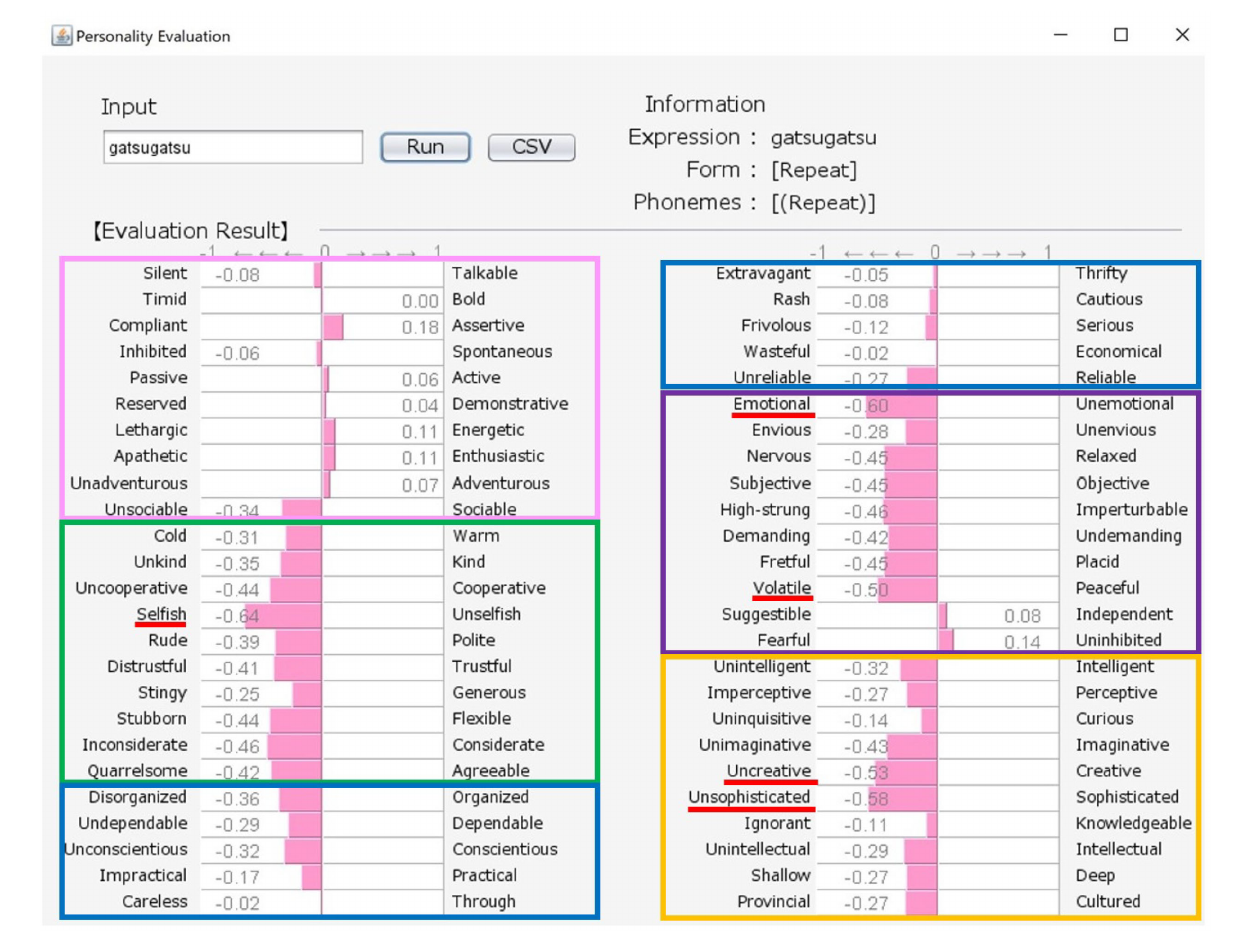
Frontiers in Psychology |